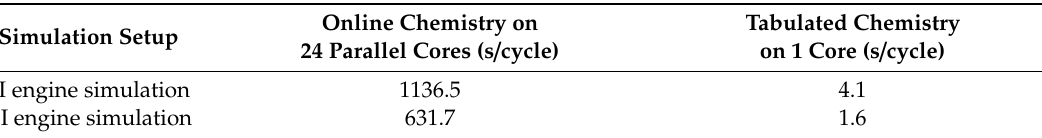
Table 10. Computational performance summary assuming SRM model settings listed in Tables 4 and 8,